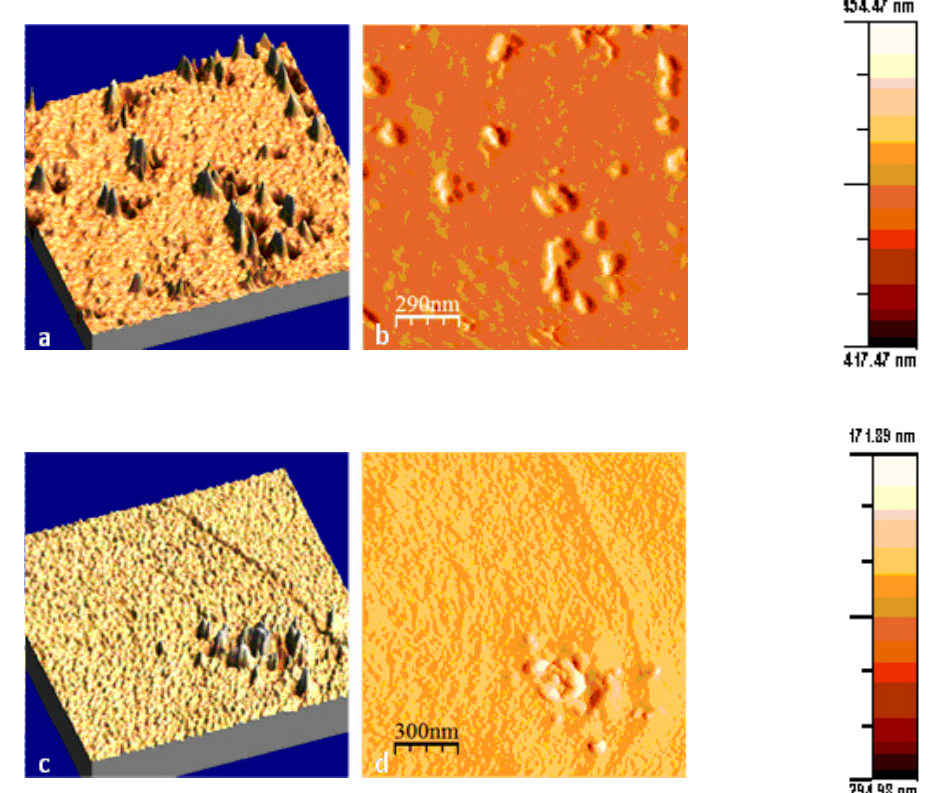
Figure 3. Atomic force microscopy (AFM) images of PIMWNT5 ( a,b ) and PIMWNT2 ( c,d ) membranes.